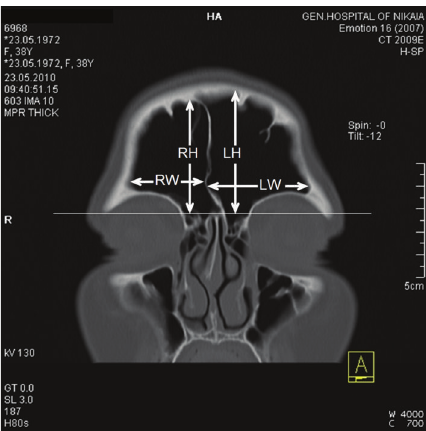
Figure 1: Linear measurements of frontal sinus in the coronal plane (RW: width of the right sinus, LW: width of the left sinus, RH: height of the right sinus, and LH: height of the left